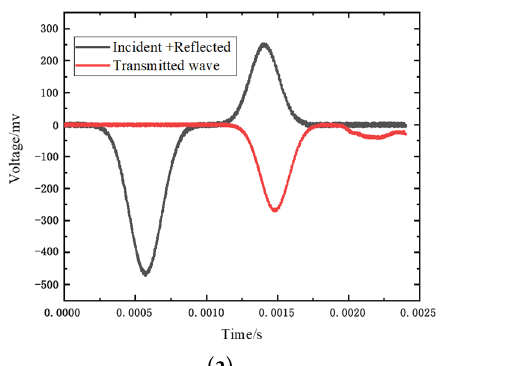
6 of 20 Figure 3. Physical photos of the test process. Table 2. Experimental program. Speeds